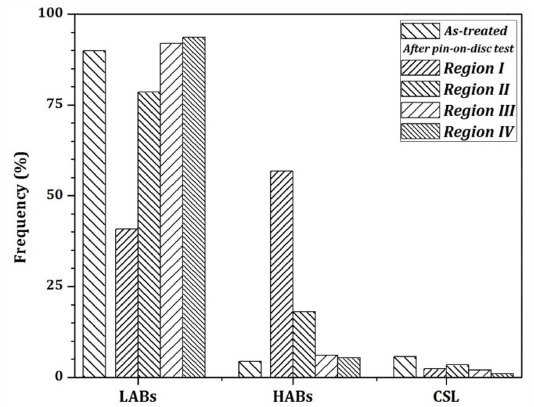
Figure 11. Boundary types distribution of specimens treated at 700°C before and after pin on disc tests.